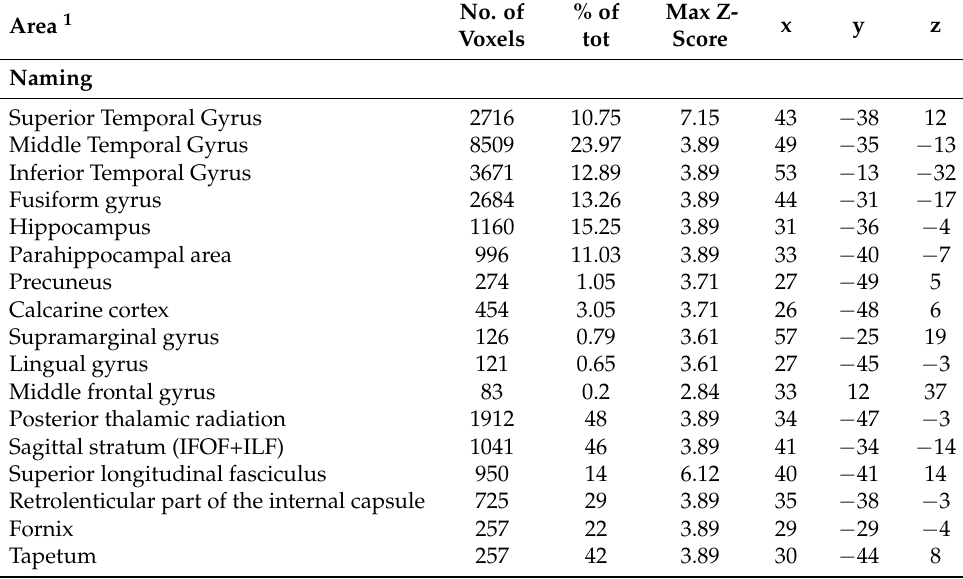
Table 4. Results of the VLSM analysis on naming and verbal comprehension (Token